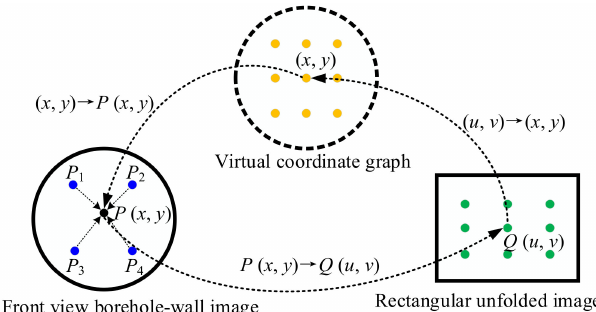
Figure 5. Virtual coordinate